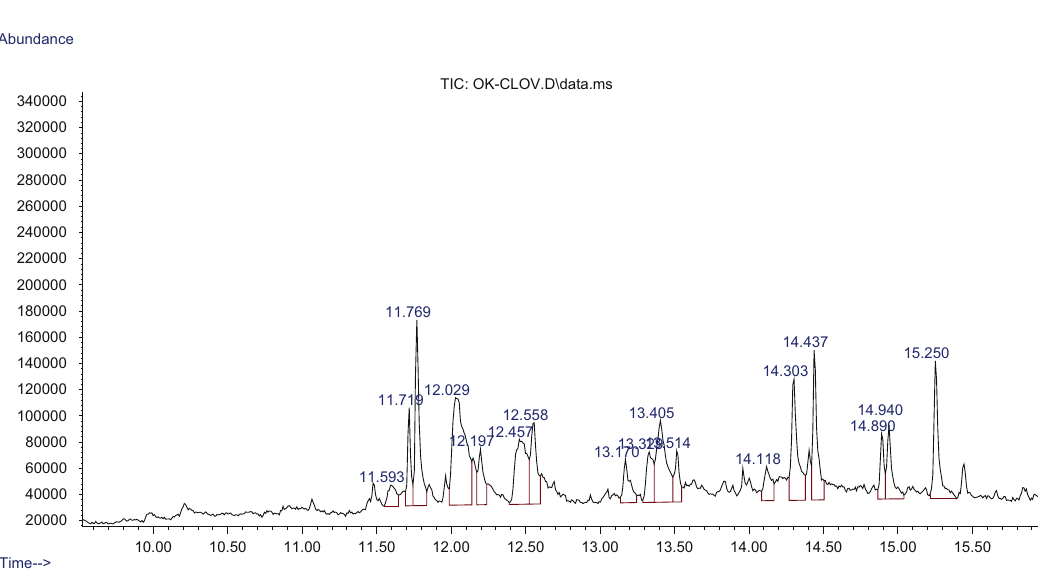
Figure 1: The analysis of the chemical contents of the Rumex vesicarius seed extract by the chloroformed solvent.